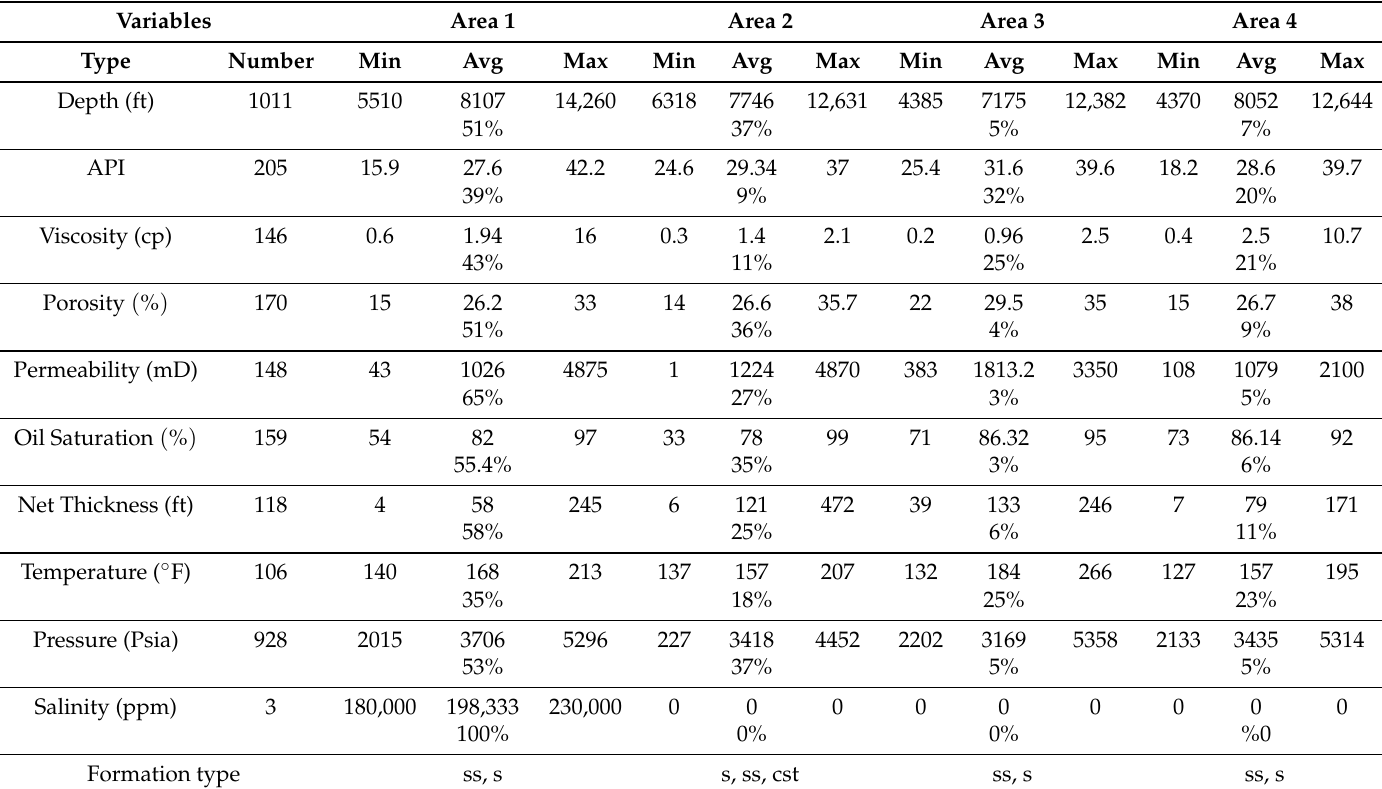
Table 4. Rock and fluid properties for some of the Angolan oilfields. The area grouping is based on production allocation for the entire reservoir investigated Block K. (Courtesy: Sonangol